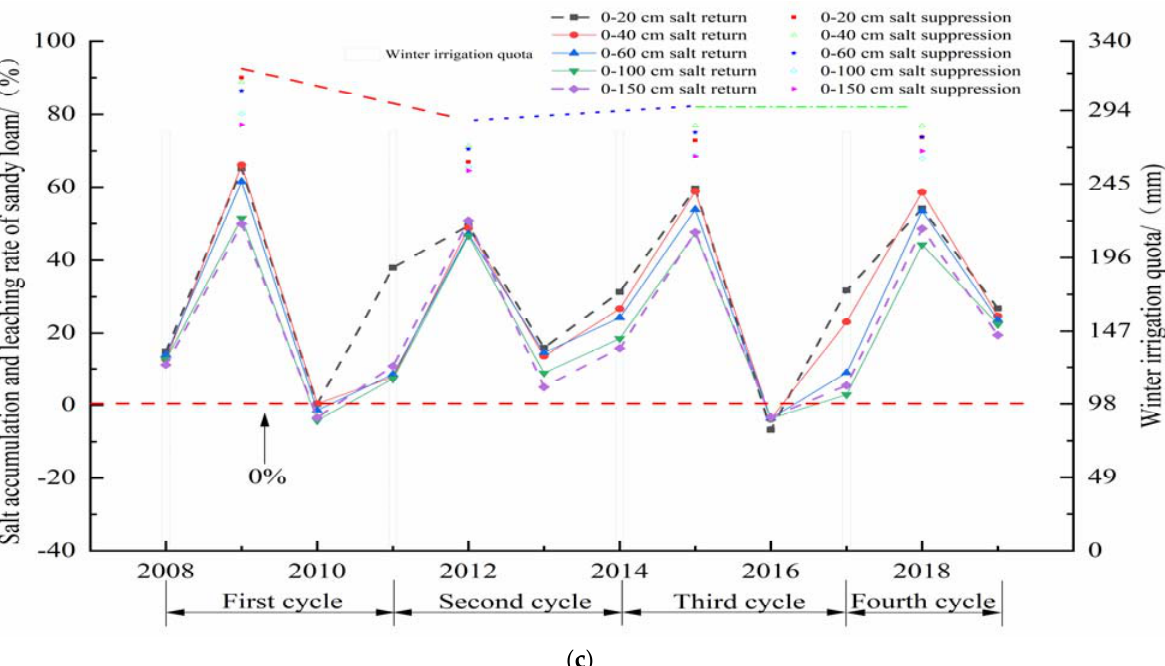
Figure 5. Analysis of salt leaching effects of different soils and salt return from farming. ( a ) Loamy clay; ( b ) loam; ( c ) sandy loam.